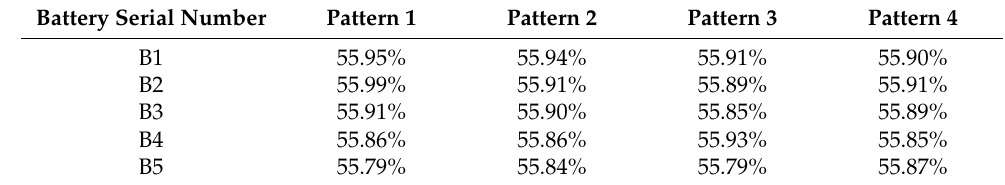
Table 6. Discharge equalization experimental data.